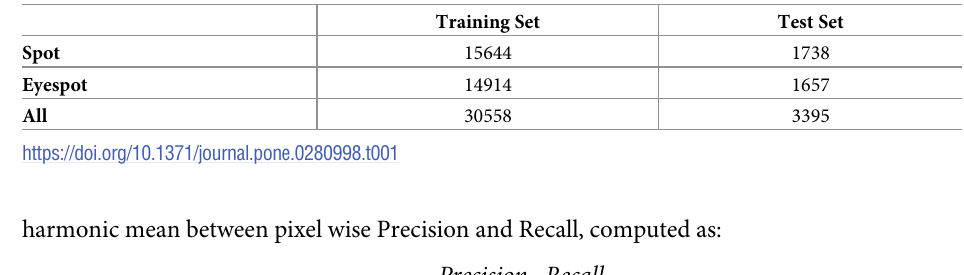
PLOS ONE | https://doi.org/10.1371/journal.pone.0280998 February 13,